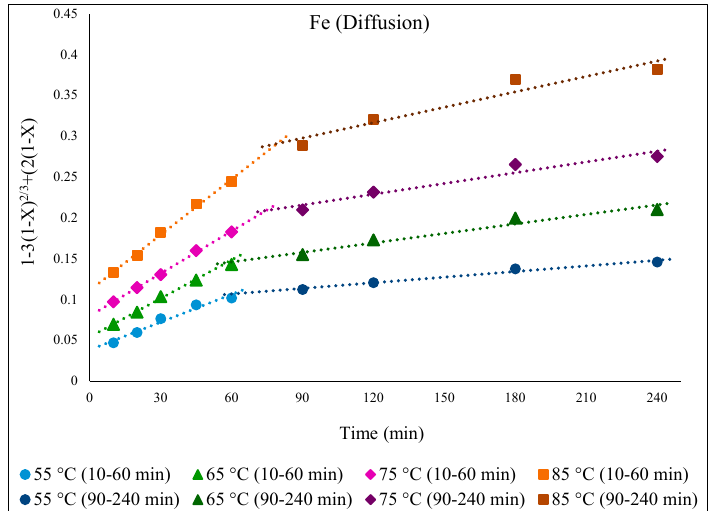
Figure 9. Graph of [1 − 3(1 − X) 2/3 + 2(1 − X) = k.t] over time at different temperatures of 55–85 °C for the dissolution of Fe from EAFD in 30% v/v [Bmim + HSO 4 − ] solution with 1 g of oxidant Fe 2 (SO 4 ) 3 . By applying the Arrhenius equation, k = Ae − Ea/RT , from the plot of ln k vs. the inverse of the studied temperatures (1000/T), the activation energy (E a ) for each part of the reac- tion can be obtained from the slope in Figure 10 (slope = − E a /R). As expected, E a for the initial part of the curve—which comprises Fe extraction from a more easily extractable phase (Fe 3 O 4 )—was lower than the second portion, which is related to Fe extraction from a phase that is more chemically resistant (ZnFe 2 O 4 ), with calculated values of 20.8 and 34.6 kJ/mol respectively. Figure 10. Arrhenius graph of ln k vs. 1000/T for the first part (10–60 min) and the second part (90– 240 min) of Fe extraction. As for Fe, the kinetic process of Zn extraction was also governed by diffusion. Figure 11 demonstrates the functionality of the diffusion equation over time (min), displaying linear relationships for Zn extraction at different temperatures (55 to 85 °C). In general, the extractable Zn comes primarily from the ZnO phase, with a minor contribution from the slower-dissolving refractory ZnFe 2 O 4 phase. Towards the latter part of the reaction, i.e., after 1 h, the extracted Zn originates mostly from the ZnFe 2 O 4 phase, as the ZnO phase has already largely dissolved [6,11].